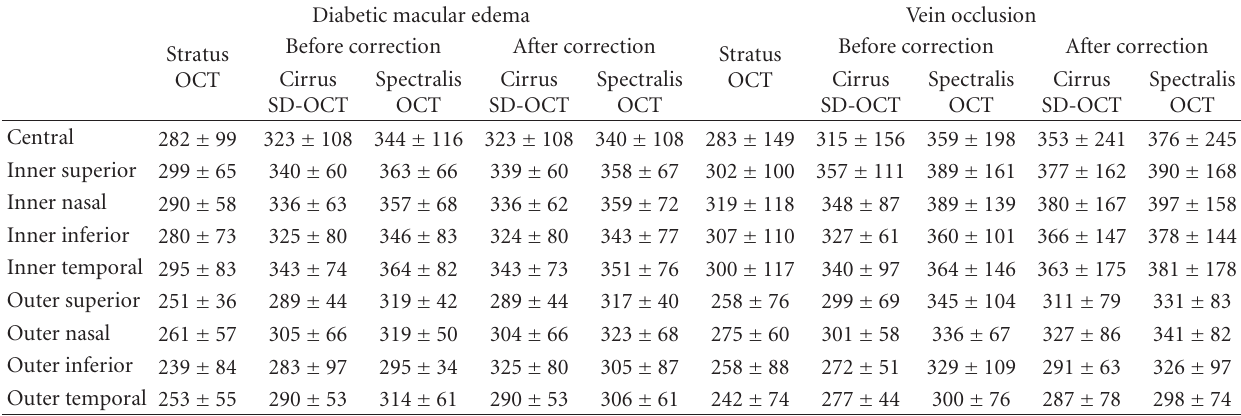
Table 1: Mean ± standard deviation of nine standard subfields of three OCT devices. Diabetic macular edema Vein occlusion Before correction After correction Before correction After correction Stratus Stratus Spectralis Cirrus Spectralis Spectralis Cirrus Spectralis OCT Cirrus OCT Cirrus SD-OCT OCT SD-OCT OCT SD-OCT OCT SD-OCT